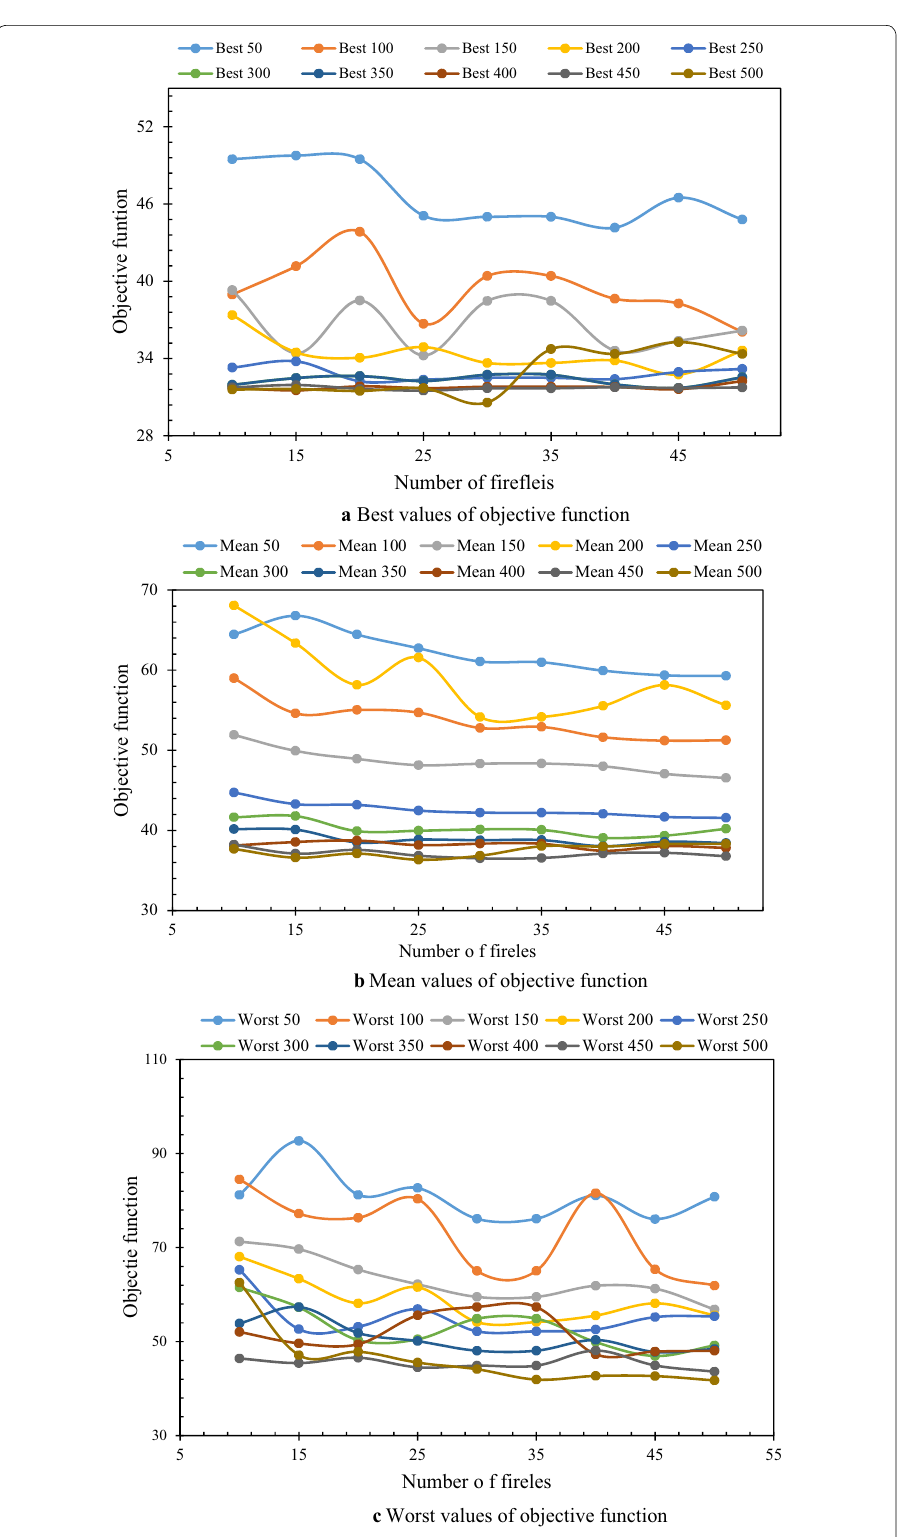
Fig. 6 Effect of variation of function evaluation on objective